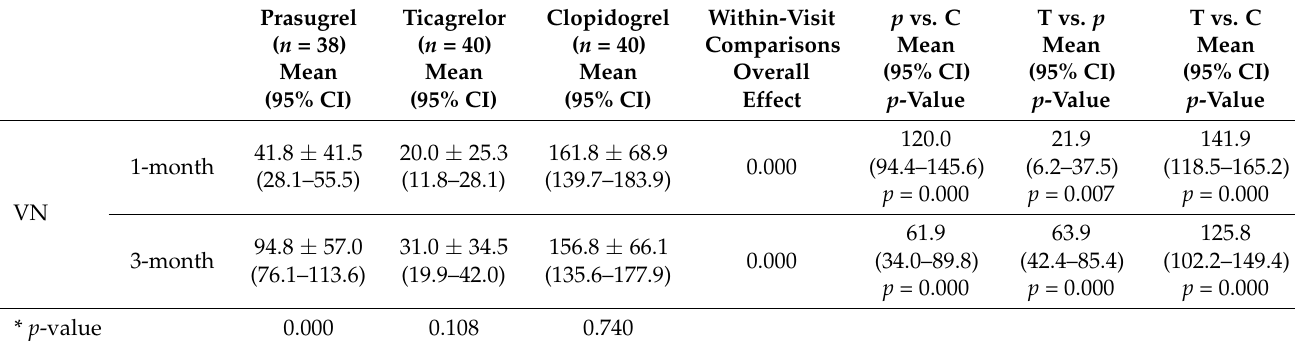
Table 2. Platelet function values during standard and reduced-dose